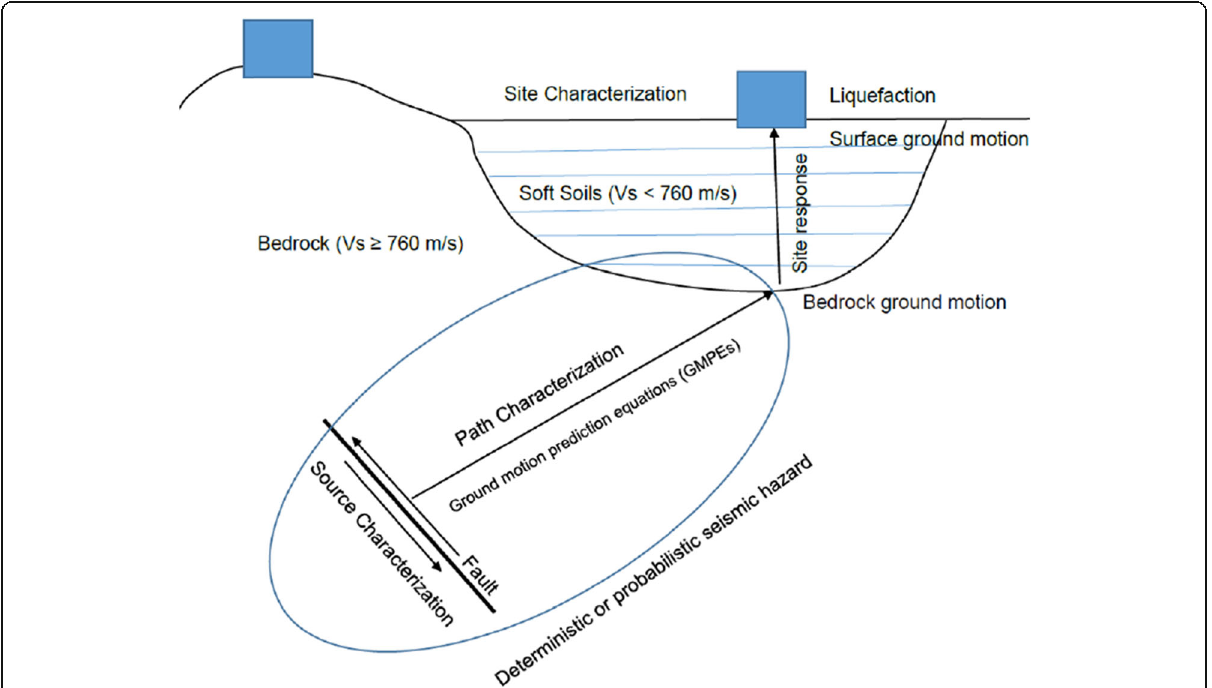
Fig. 8 Conceptual Components of seismic hazard analysis (Rahman